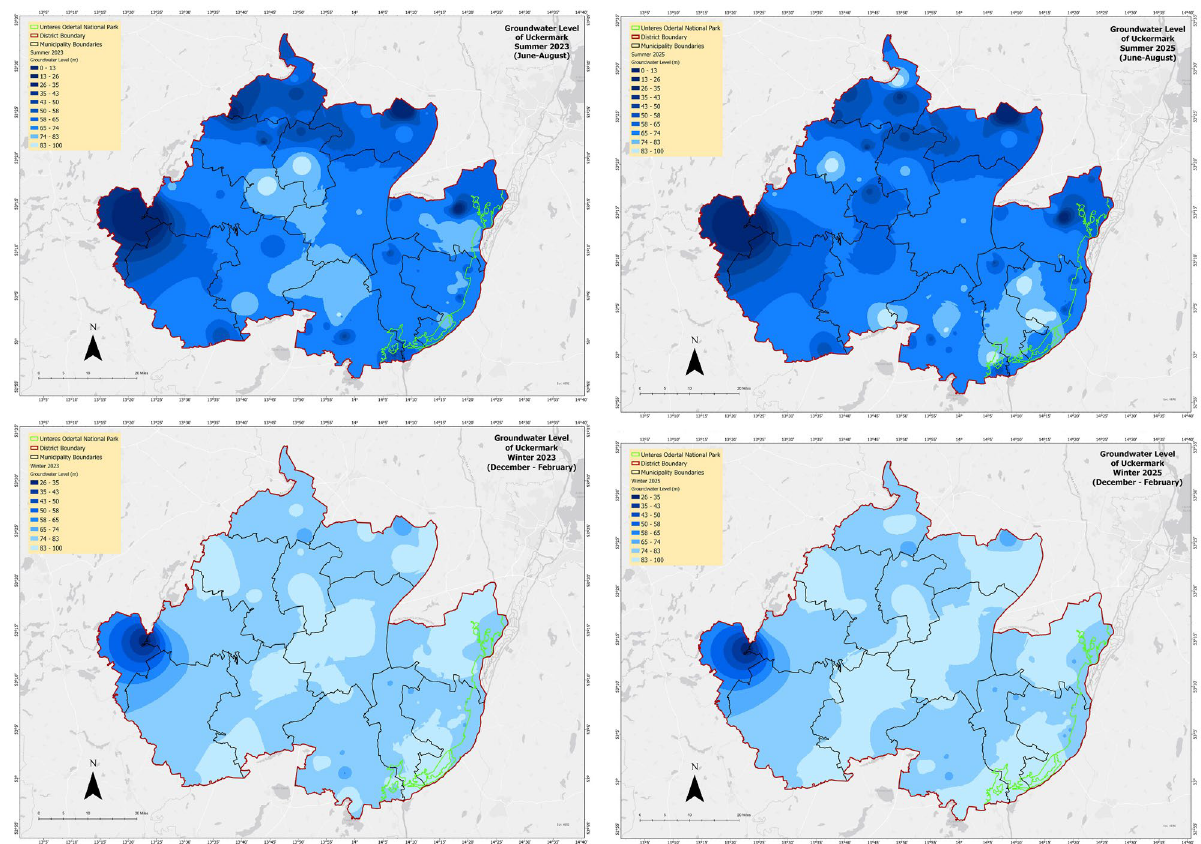
Figure 15. Predicted groundwater level conditions of two seasons (2023, 2025) in